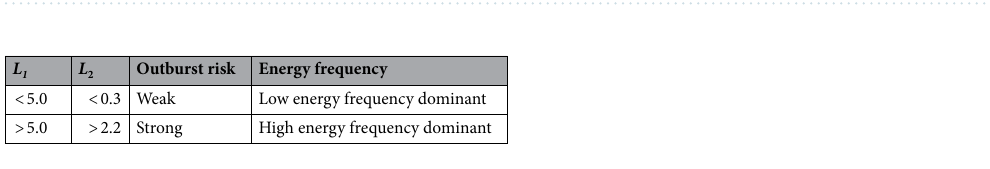
Table 4. Risk index of coal and gas